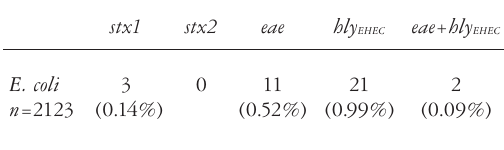
Table 3. Occurrence of E. coli toxin genes in 2123 iso- lated strains (prevalences in parentheses)